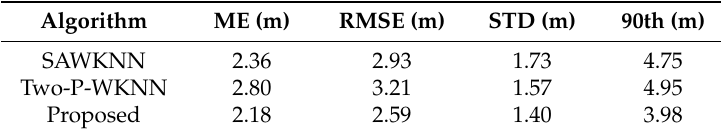
Table 3. Positioning performance comparison of the three algorithms.